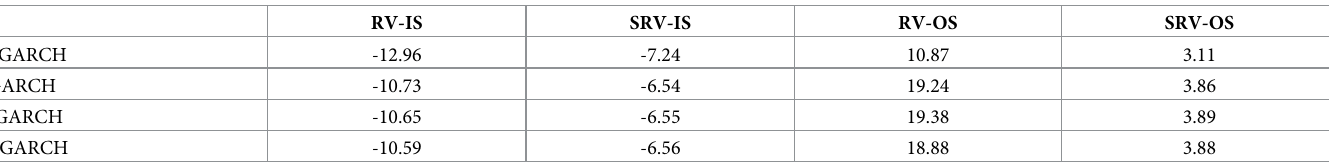
Table 11. QLIKE loss function results for four models. This table reports the QLIKE loss function results for the model performance comparison regarding the four models. SRV represents the simplified realized variance, IS represents the in-sample results (from year 2000-2010) and OS represents the out-of-sample results (from year